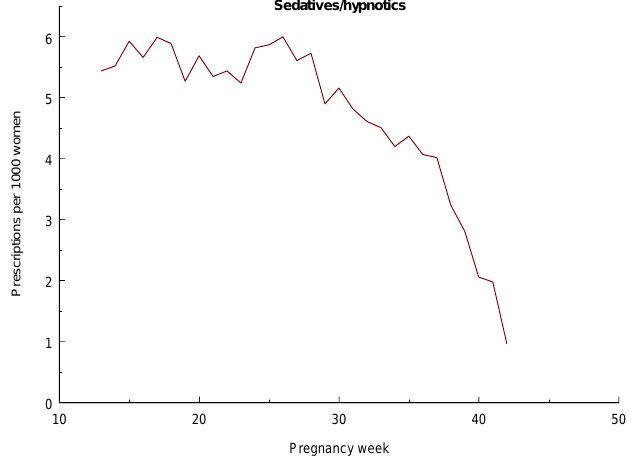
Figure 5. Diagram showing number of women per 1,000 who had filled a prescription for a sedative or hypnotic drug for each gestational week.